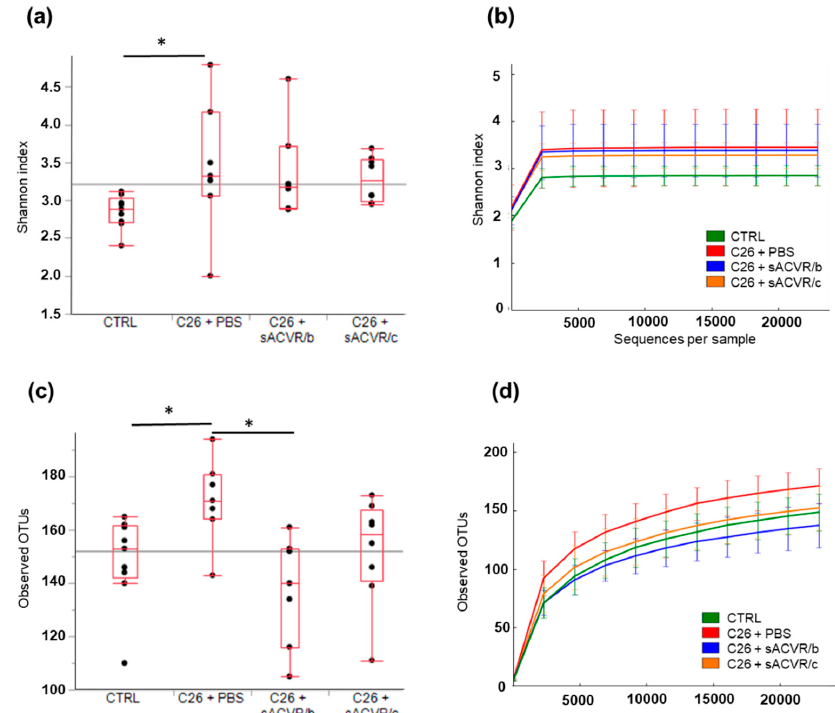
Figure 1. Alpha-diversity of the mice gut microbiota samples. ( a ) Based on average Shannon indices, or ( b ) Shannon indices shown as sequences per sample, the microbiota of the control (CTRL) samples was significantly less diverse than in the other groups. ( c ) The average operational taxonomic unit (out) richness and ( d ) the OTUs shown as sequences per sample of the C26 + PBS group gut microbiota tended to be higher than in other samples. Phosphate buffered saline (PBS), a systemic blocker of activin receptor 2B ligands (sACVR2B), Control (CTRL, n = 9), cancer (C26 + PBS, n = 7), the group that received sACVR2B until tumor formation (C26 + sACVR/b, n = 7), and the group that received sACVR2B until death (C26 + sACVR/c, n = 8). * Denotes statistically significant difference between the groups. Cancers 2019 , 11 , x